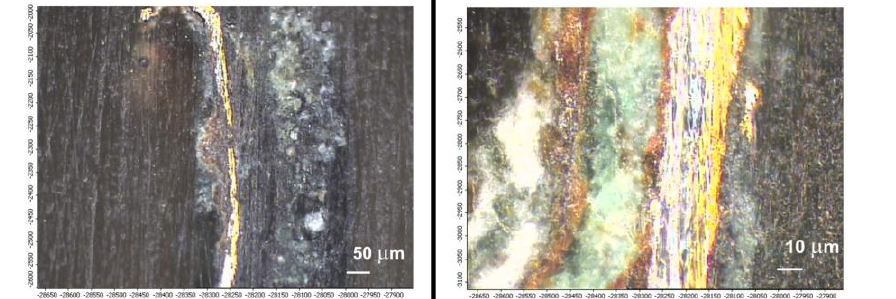
Figure 19. Section of sample from point 1 in Figure 15. Photographs registered using a Raman system microscope (section presented in Figure